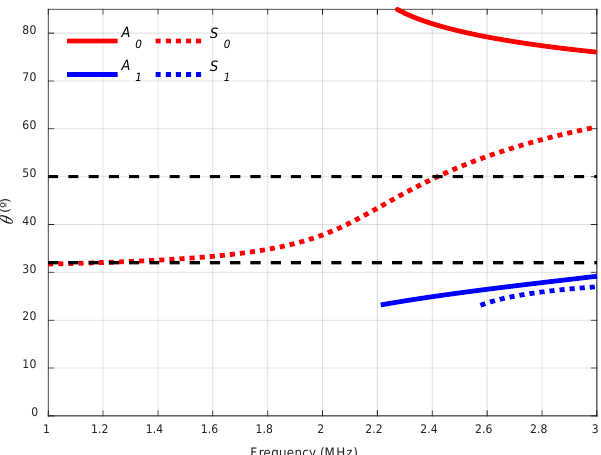
Figure 6. Incidence angle dispersion curves for a stainless steel plate and Plexiglas as the coupling medium ( c = 2730 m / s). The chosen angles (32 ◦ , 50 ◦ ) are represented by black discontinuous curves.